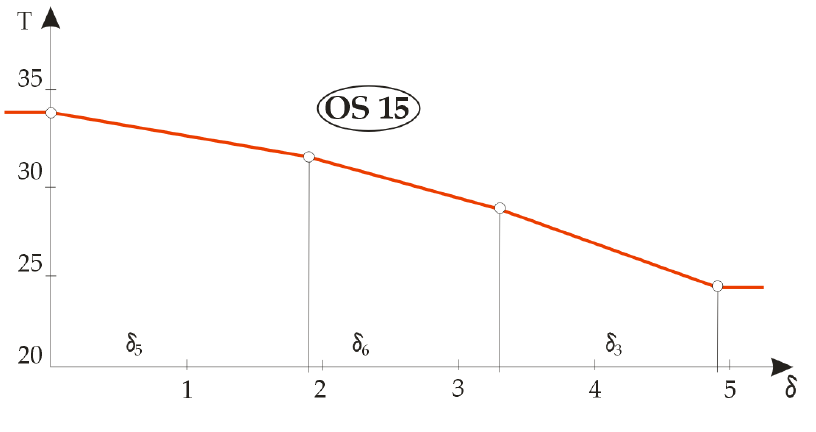
Figure 9. Graphical representations of the temperature gradients for different combinations of arti- cles of three-layer composite